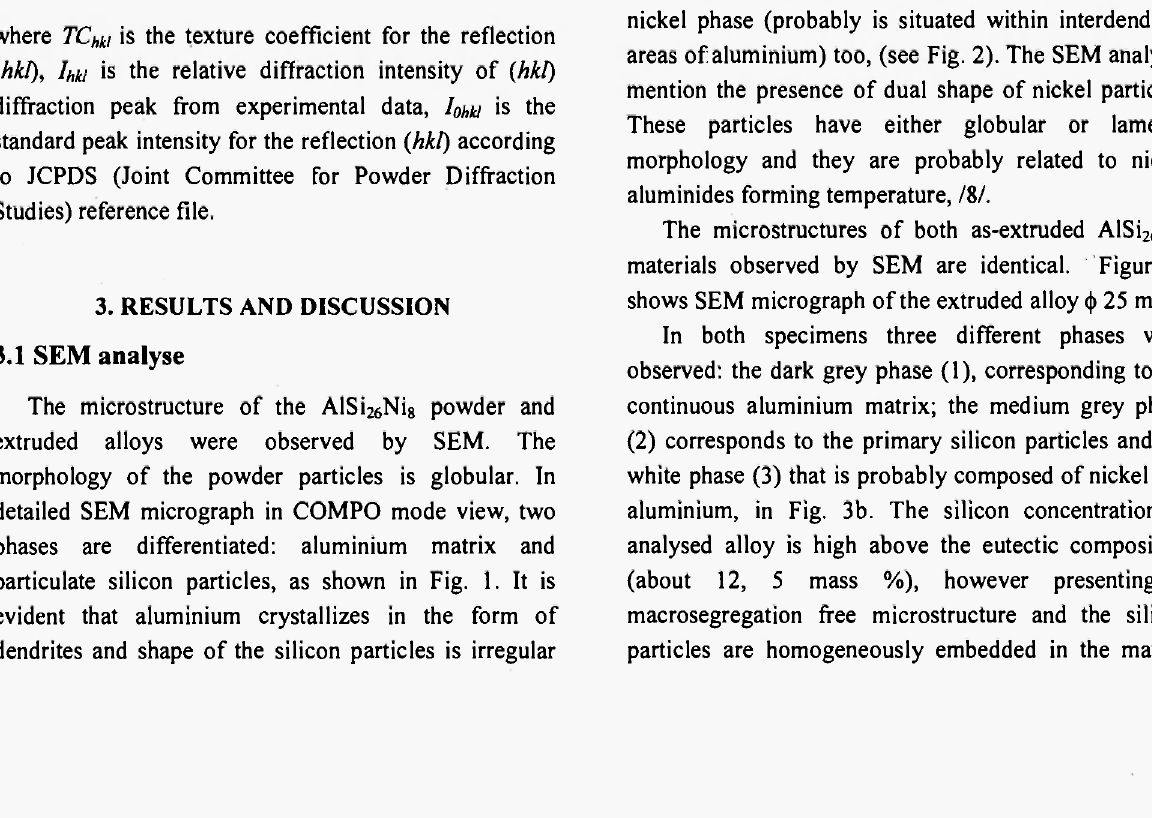
and angular. Following high cooling rate the aluminium matrix crystallizes only in the form of very fine dendrites. The particulate silicon particles arise from the rapid solidification processing. The presence of